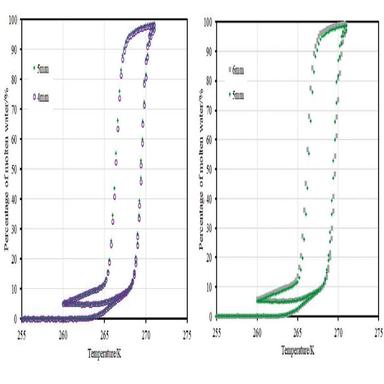
Pairwise comparisons (a–f) of cryoporometry melting and freezing curves for internal (i.e. non-end) MRI slices of extrudate, each indicated by the distance of the proximal edge from one end of the extrudate, as shown in